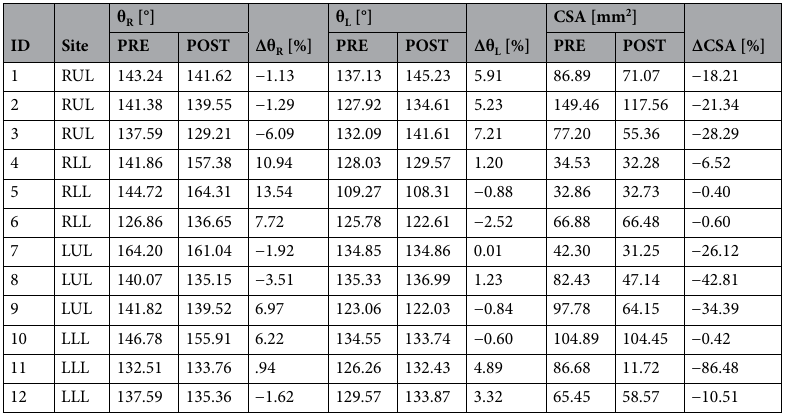
Table 2. Measured values of θ R , θ L , and CSA in the pre and post-operative cases. The percentual variation with respect to the pre-operative case is also reported.